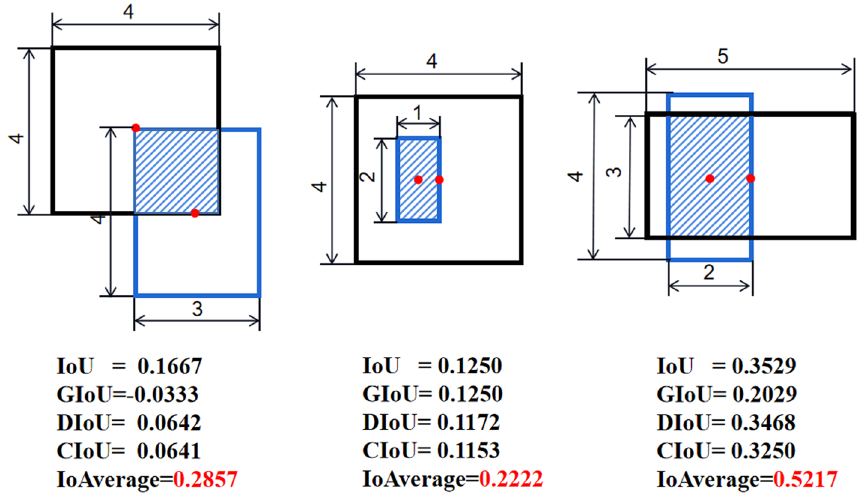
Fig. 5 The results of five schemes in three